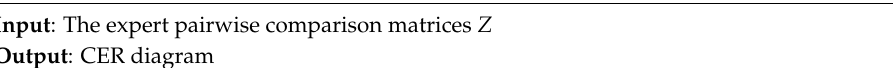
Algorithm 1: IRN-DEMATEL